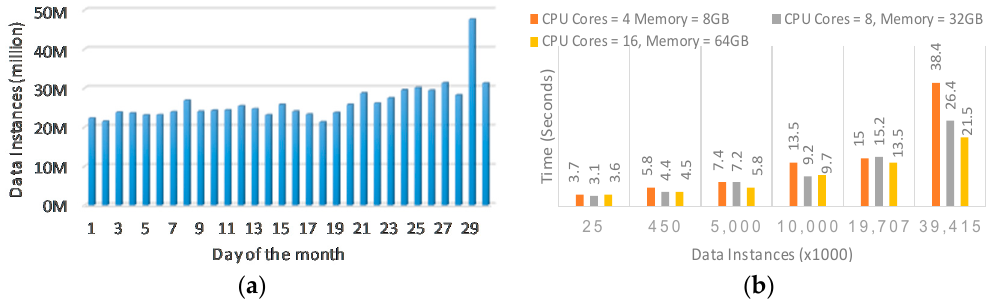
Figure 12. Flow-centric visibility verification results. ( a ) The number of visibility data instances collected for a month and ( b ) execution time of visibility integration component.